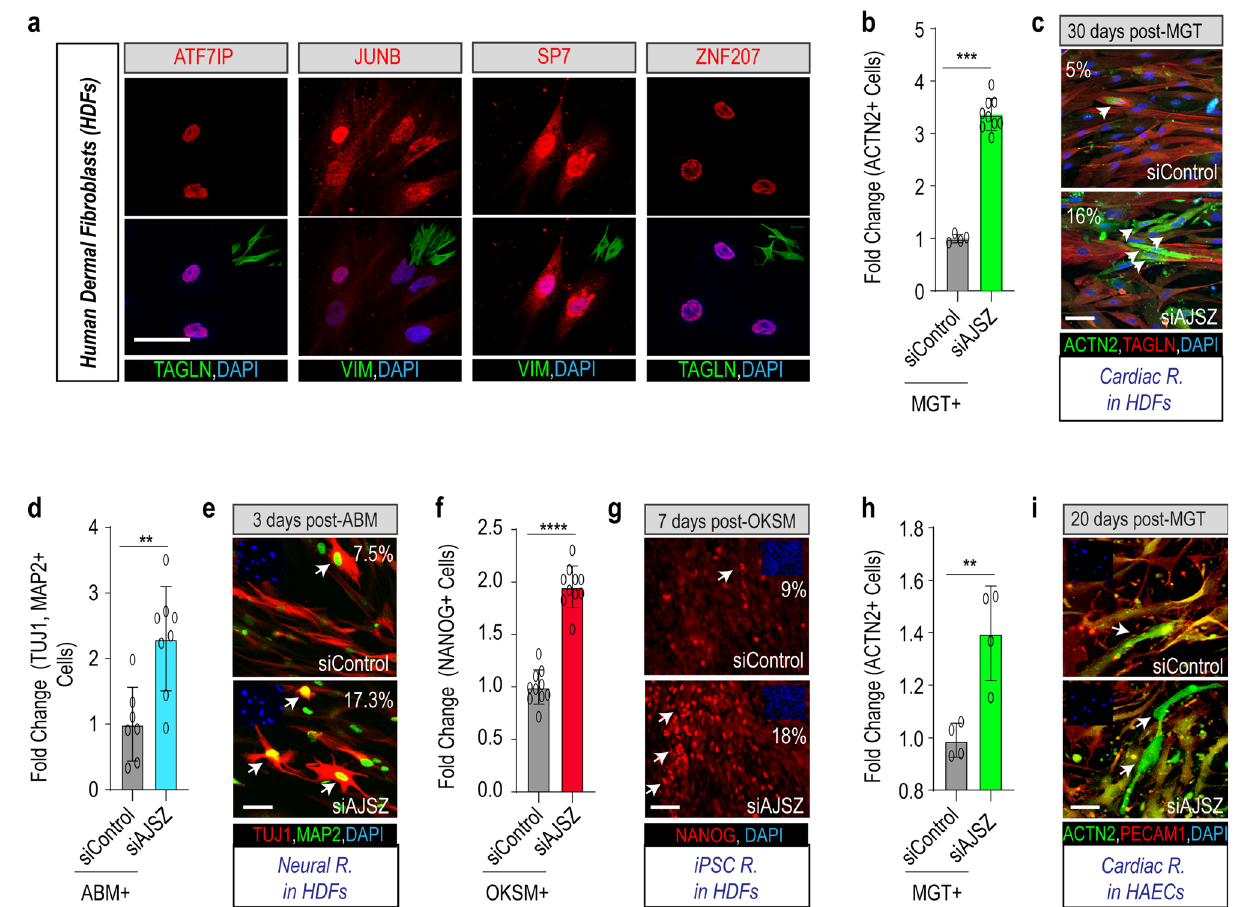
Fig. 2 | Lineage- and cell type-independent role for AJSZ as barriers to repro- gramming.a ExpressionofAJSZinHDFs.ImmunostainingforAJSZisshowninred and fi broblast markers Vimentin (VIM) or Transgelin (TAGLN) are shown in green. Nuclei are stained with DAPI. n =4 per condition. b Quanti fi cation of the % of cardiac marker ACTN2-expressing cells normalized to MGT+siControl condition after 30 days of cardiac reprogramming in HDFs. n =5 and n =9 for siControl and siAJSZ treated, respectively. c Representative images of HDFs treated with MGT+ siControl or MGT+siAJSZ and immunostained for cardiac (ACTN2, green) and fi broblast(TAGLN,red)markers.Nucleiarestained withDAPI(blue).Whitearrows indicate iCMs. d Quanti fi cation of the % of MAP2 (green) and TUJ1 (red)-double- positive cells, 3daysafteroverexpression of Ascl1, Brn2, andMytl1 (ABM)in HDFs. n =7 and n =8 for siControl and siAJSZ treated, respectively. e Representative imagesofHDFstreated withABM+siControlorABM+siAJSZand immunostained forMAP2(green)andTUJ1(red).NucleiarestainedwithDAPI(blue,topleftinsets).